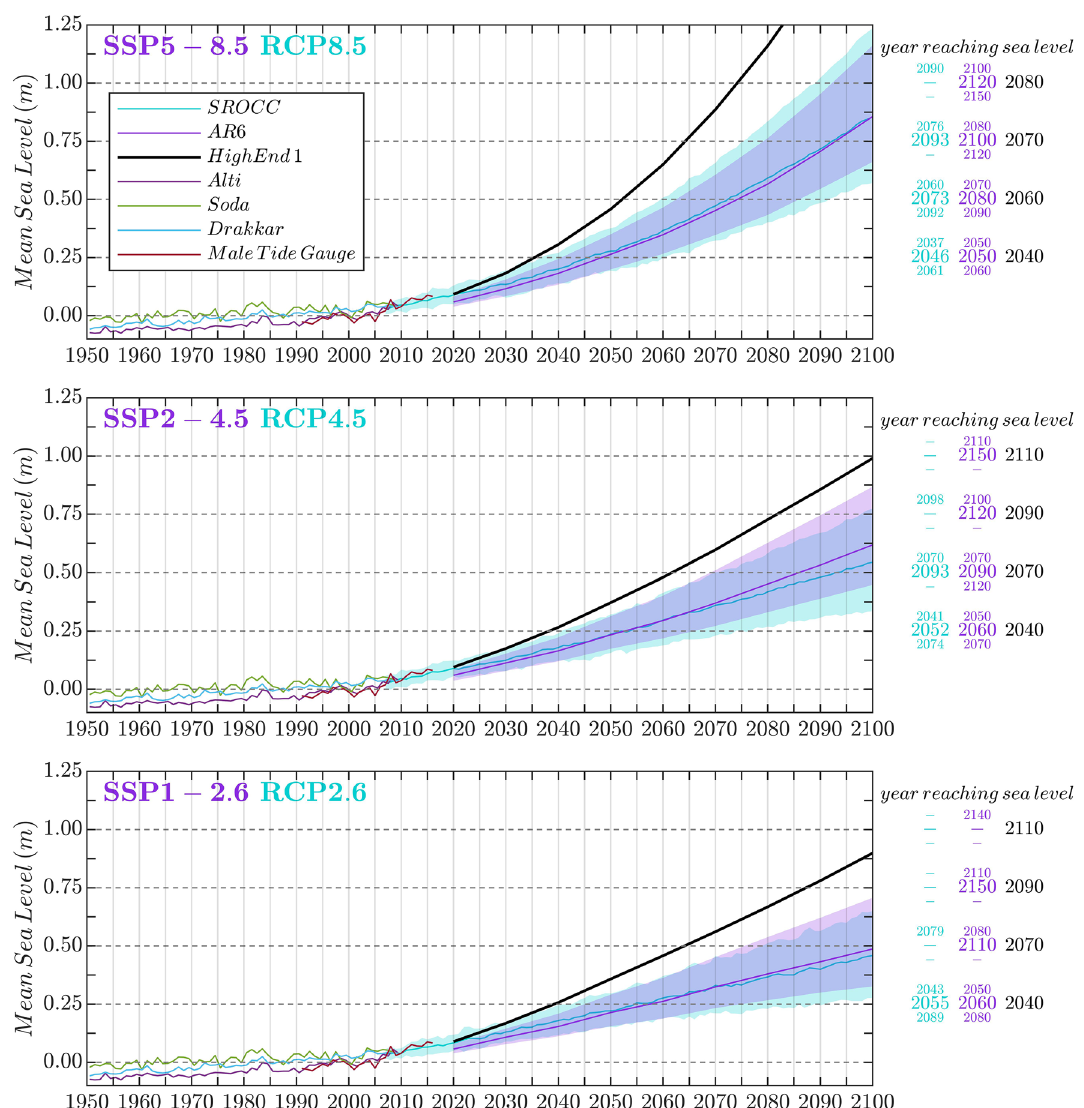
Figure 3. Mean sea-level reconstructions from observations (1950–2000) and likely projections, median and high-end scenarios for the Maldives (Malé) during the 21st century (based on data and methods of 18,28,56,58,59 ), with the associated periods of time by which elevations of 0.25, 0.5, 0.75 and 1 m are projected to be exceeded, with respect to the average mean sea level of